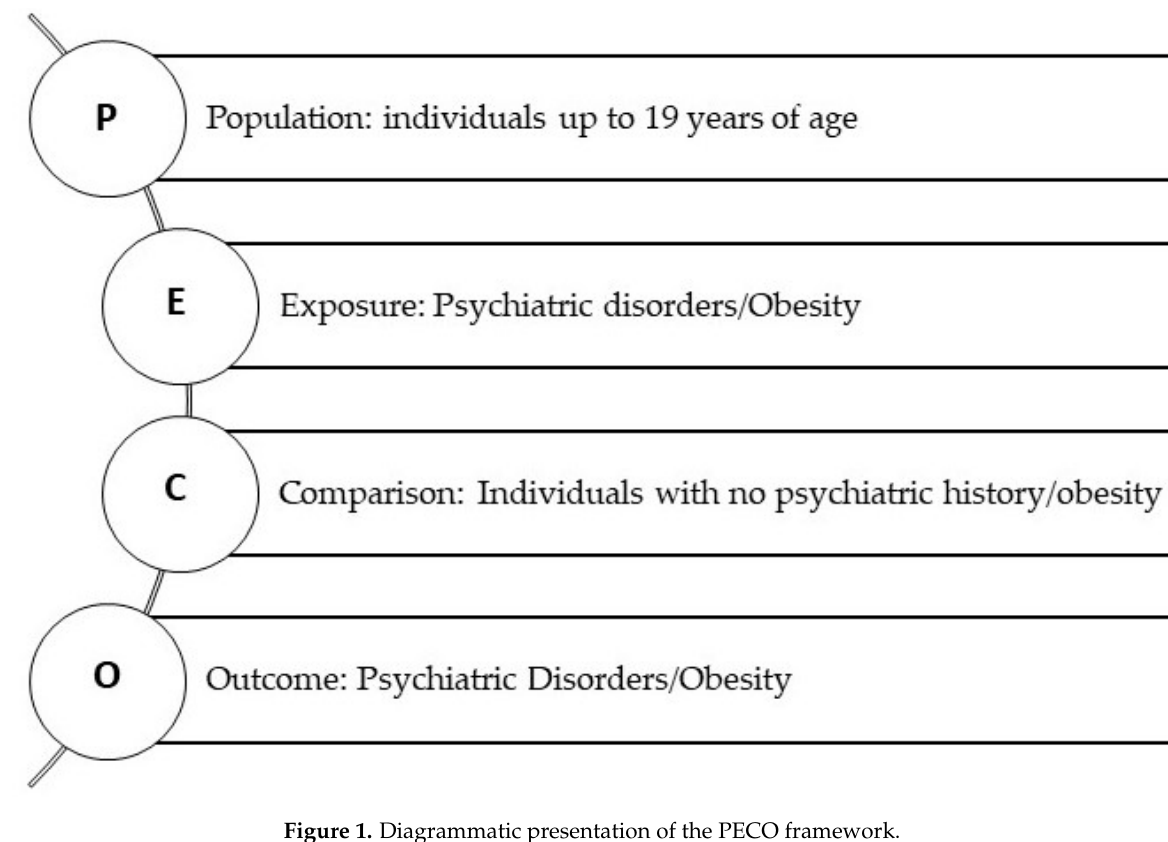
Figure 1. Diagrammatic presentation of the PECO framework.